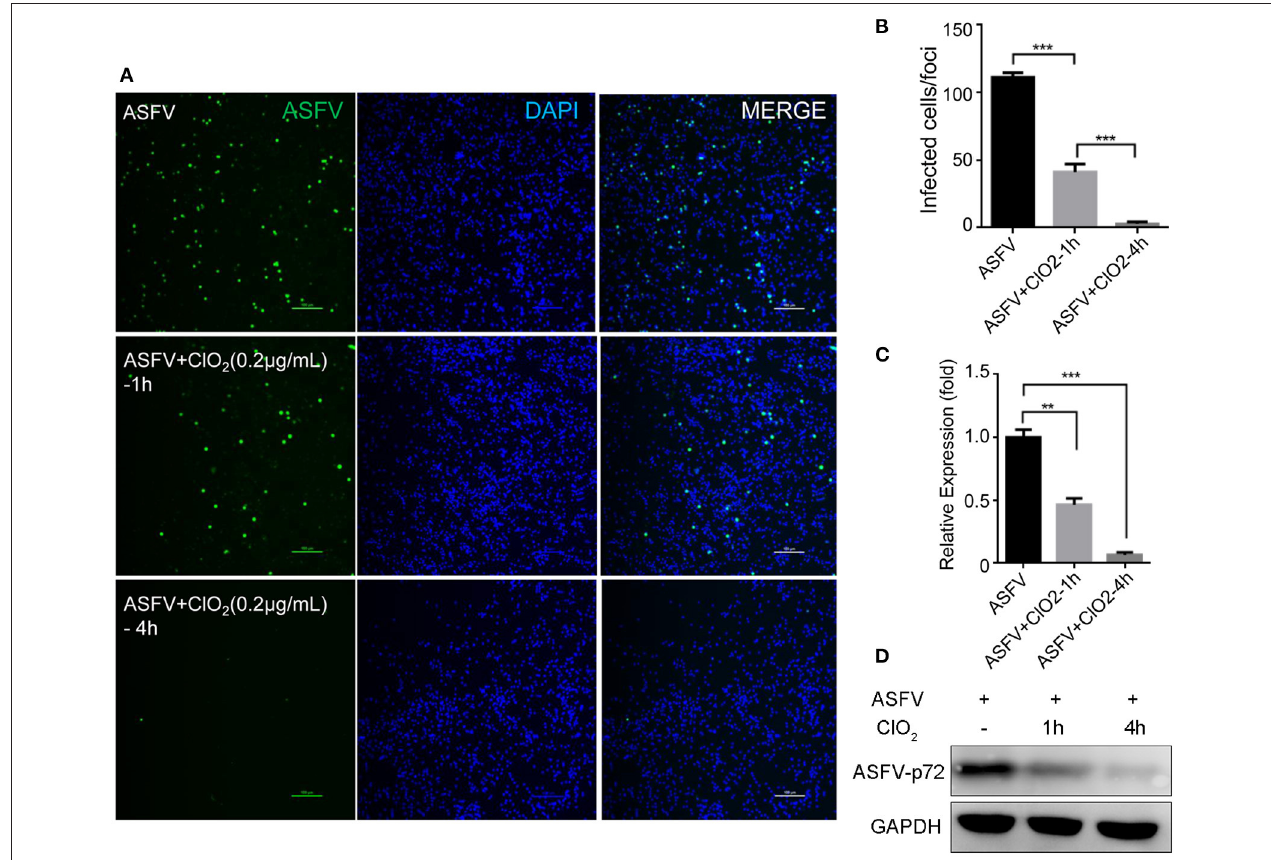
FIGURE 4 | ClO 2 displays a strong extracellular virucidal effect on ASFV. (A,C,D) ClO 2 at the concentration of 0.2 µ g/mL was pre-incubated with ASFV (MOI = 1) for 1 or 4h at 37 ◦ C, and then the mixtures were diluted and added to PAMs for 2h at 37 ◦ C. Finally the mixtures were removed and cells were replenished with fresh RPMI-1640 supplemented with 2% FBS and cultured for additional 24h. IFA was performed to detect the expression of viral protein using an anti-ASFV p30 mAb (A) . The mRNA and protein levels of virus p72 were examined by qRT-PCR (C) and western blot (D) analysis, respectively. Bar, 100 µ m. (B) Average number of infected cells per foci. Data are representative of the results of three independent experiments (means ± SE). Significant differences compared with control group are denoted by ** P < 0.01 and *** P <